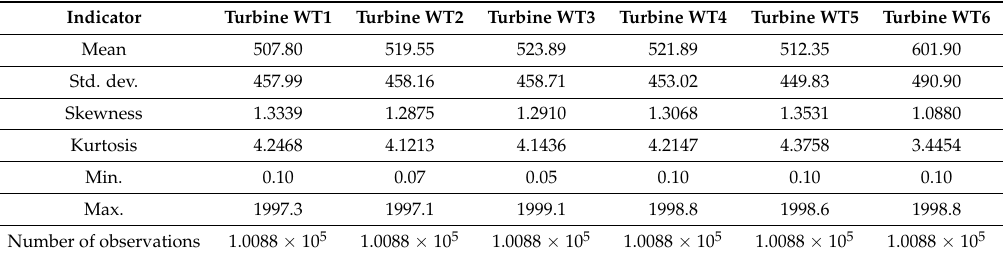
Table 1. Descriptive wind power statistics. WT: wind